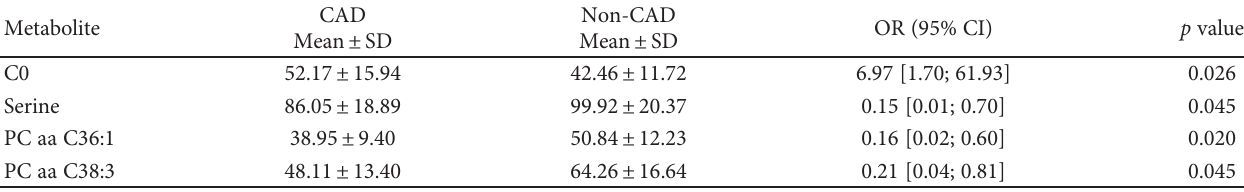
Table 2: ORs for the selected metabolites using logistic regression analysis in 57 T2D patients. Independent variables used in multiple logistic regression analysis: sex, age, BMI, HbA1c, diabetes duration, SBP, DBP, antihypertensive, triacylglycerols, LDL :HDL ratio, lipid-lowering agents, albumin, and eGFR. ORs are presented as change in concentrations per one SD.